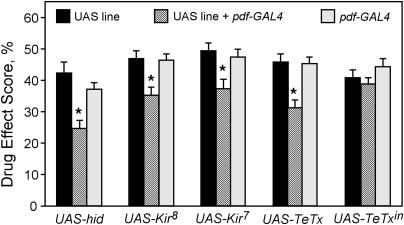
Silencing or Ablating PDF Cells Induces Resistance to CocaineAblation of PDF cells with pdf-GAL4 and UAS-hid reduced sensitivity to cocaine compared to parental lines (pdf-GAL4/+ and UAS-hid/+). Electrical (UAS-Kir2.18 or UAS-Kir2.17) or synaptic (UAS-TeTx) silencing of PDF cells with pdf-GAL4 phenocopied PDF cell ablations. One-way ANOVAs with post hoc planned comparisons revealed a significant effect of genotype for the UAS-hid (p < 0.003, n = 20), UAS-Kir2.17 (p < 0.008, n = 32), UAS-Kir2.18 (p < 0.002, n = 28), and UAS-TeTx (p < 0.001, n = 28) groups, but not for UAS-TeTxin (p > 0.045, n = 28) (n corresponds to the number of experiments). Critical p-value was adjusted to p = 0.025. Asterisks denote significant differences in both planned comparisons (pdf-GAL4/+ and UAS-transgene/+ versus pdf-GAL4/UAS-transgene). Variations in phenotype of pdf-GAL4 flies for each set of experiments is caused by day-to-day variability.